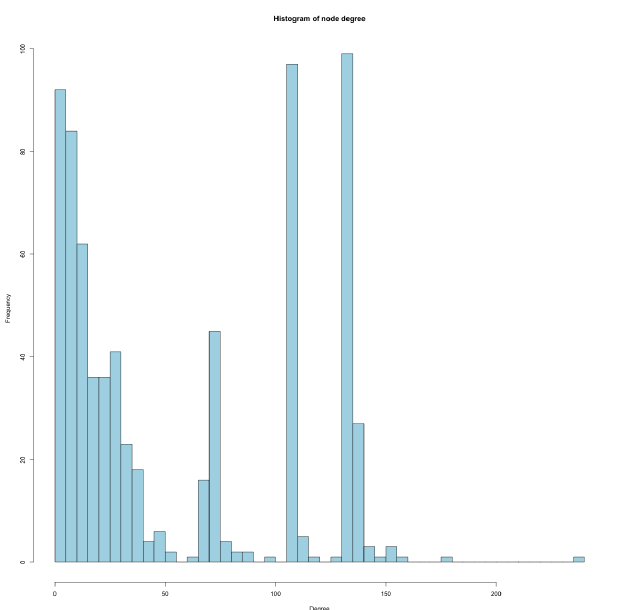
Figure 17. Channel network from the LN mainnet, first interval.